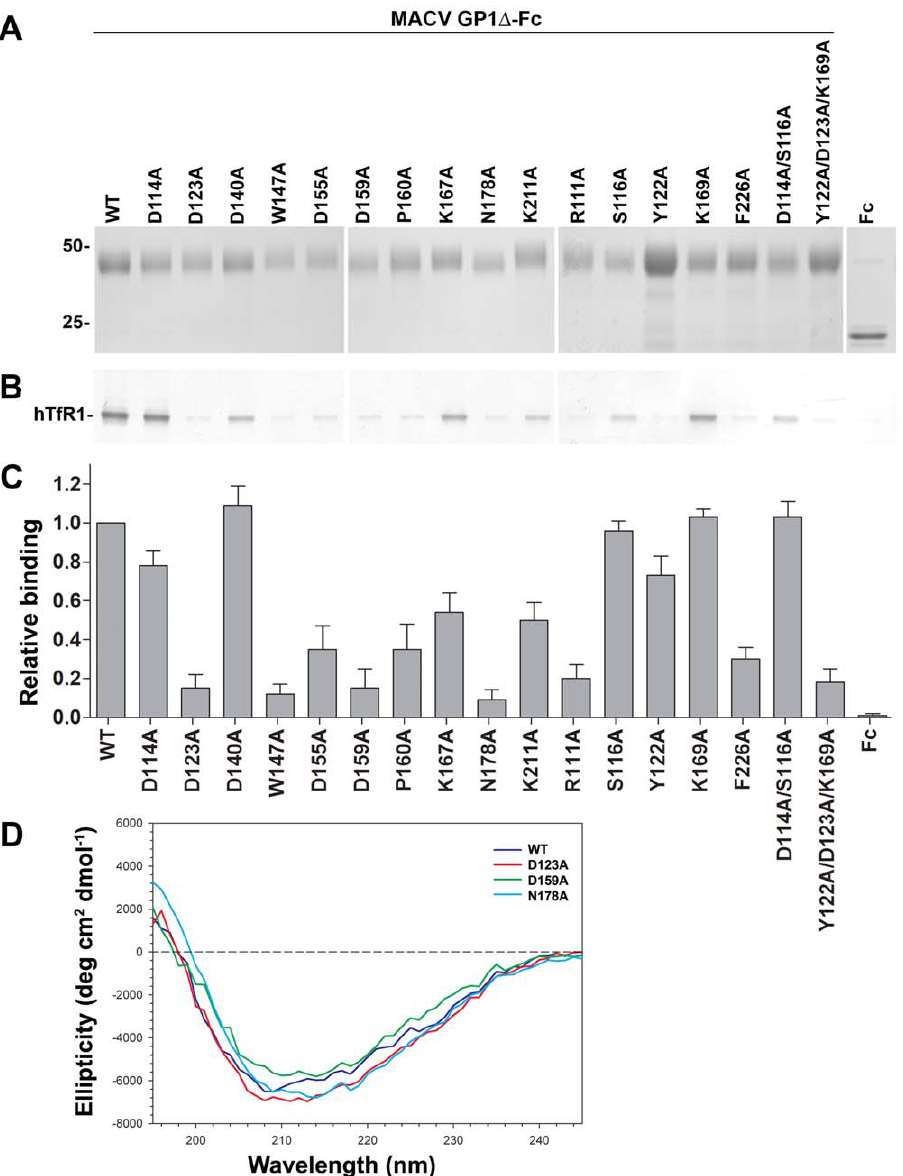
Figure 2. Binding of MACV GP1 D variants to hTfR1 and the surface of MACV-susceptible cells. A, expression of wild-type MACV GP1 D , mutants thereof, and Fc control. The numbers to the left of the blots indicate relative molecular mass in kDa. B, ability of wild-type MACV GP1 D and variants thereof to co-immunoprecipitate hTfR1. Shown is a representative western blot from two independent experiments. C, ability of these proteins to bind to the surface of MACV-permissive (Vero) cells as analyzed by flow cytometry. This assay was performed twice in duplicates yielding similar results. Bars indicate average of duplicates in one representative experiment. Results were normalized by subtracting measurements with secondary antibody only. D, far-UV circular dichroism (CD) of wt GP1 D and mutants D123A, D159A, and N178A.